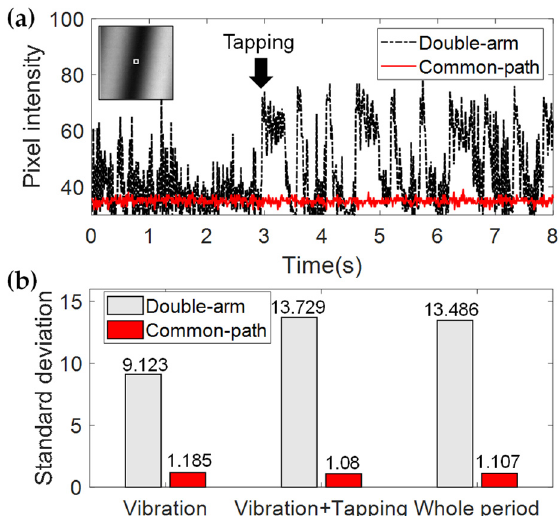
Figure 2. Interference signal stabilization using the proposed method. ( a ) Time-course interference signal intensities in the presence of surrounding noise (0–3 s vibration, 3–8 s vibration + tapping). Despite the external noise, the signal magnitude (red line) is stabilized by the proposed common- path interferometer (Video S2), whereas for the existing double-arm interferometer, the magnitude (dotted line) experiences considerable fluctuations (Video S1). ( b ) Comparison of the fluctuation in magnitudes with the corresponding standard deviations for each